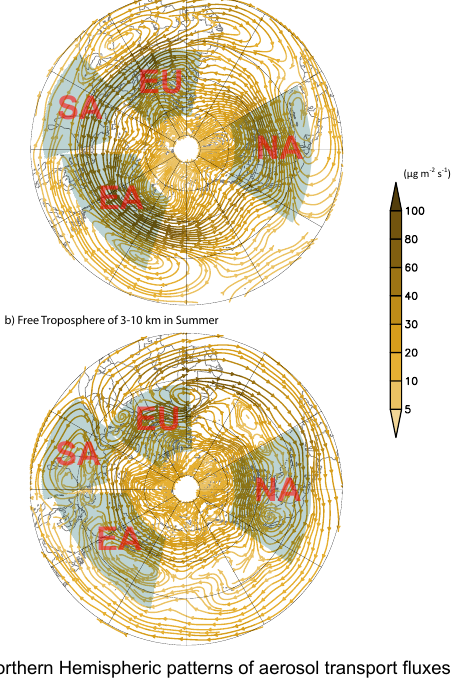
Fig. 6. Same as in Fig. 3, but for the SA-region.